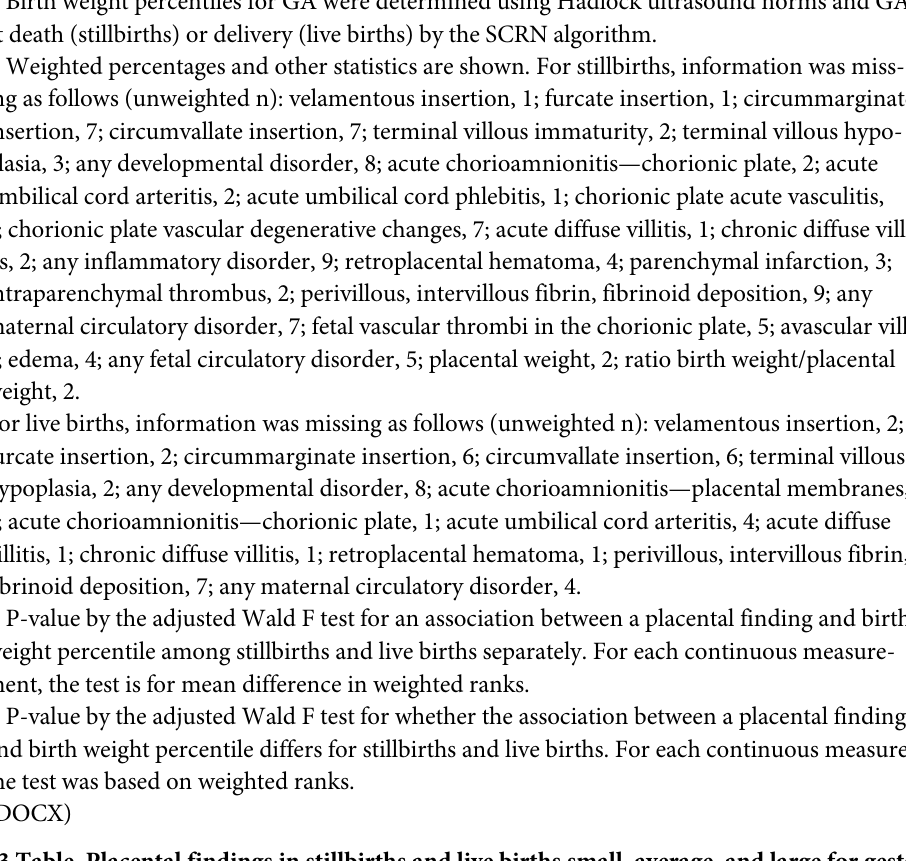
S3 Table. Placental findings in stillbirths and live births small, average, and large for gesta- tional age 32–36 weeks 1/